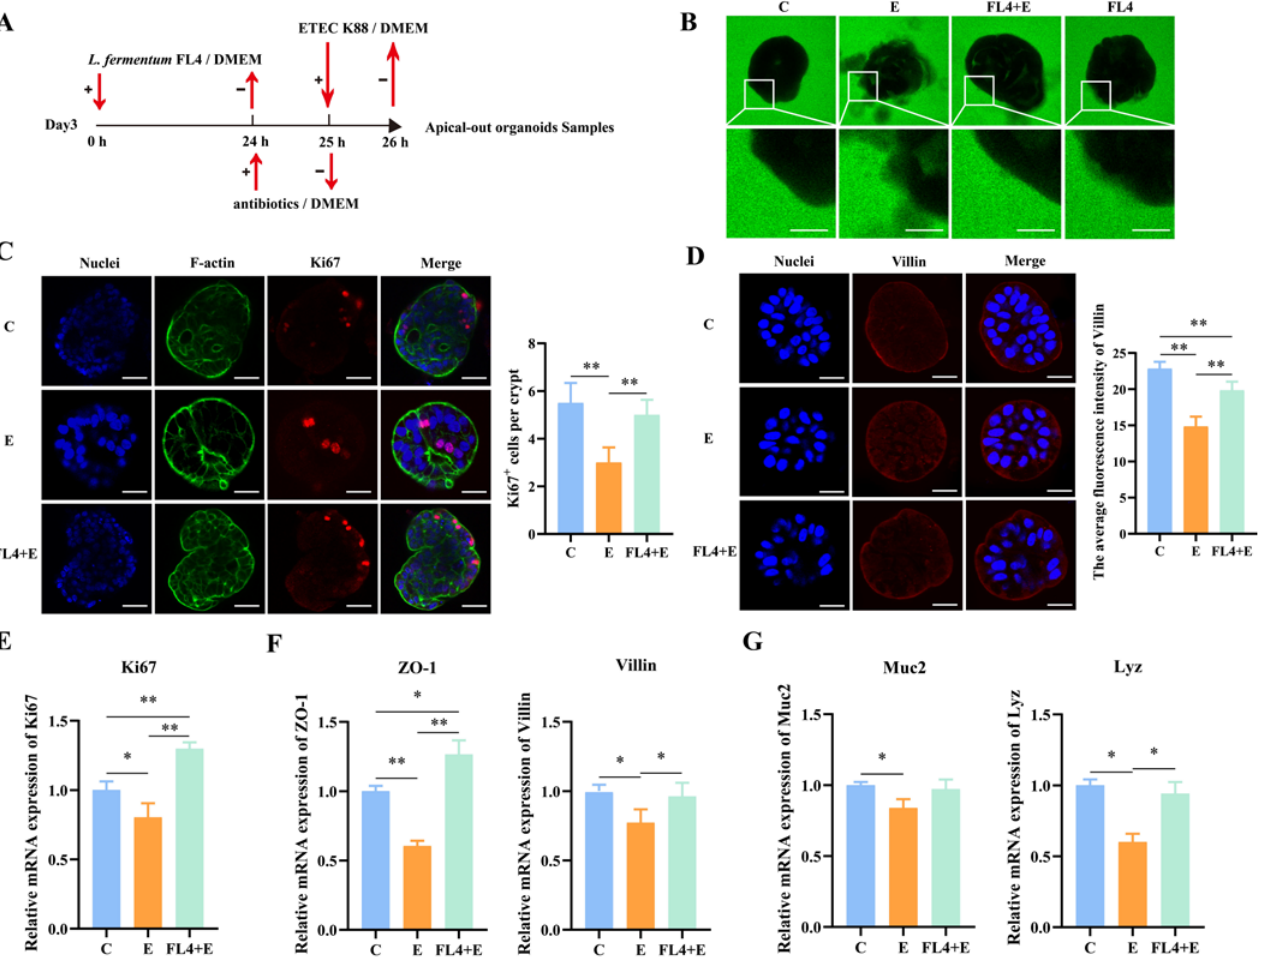
Figure 8. L. fermentum FL4 repaired the ETEC K88-induced damage to intestinal epithelium in apical-out intestinal organoids. ( A ) Experimental procedure: apical-out organoids were treated with 10 6 CFU/well L. fermentum FL4 at 0 h (Day 3) and then supplemented with antibiotics at 24 h. The organoids were further challenged with 10 6 CFU/well ETEC K88 and the samples were collected at 26 hours. ( B ) Apical- out organoids were imaged by using confocal fluorescence microscopy to ob- serve epithelial barrier integrity in different treatmen ts. Scale bars, 50 µm. ( C , D ) Apical-out organoids were stained with Ki67 and Villin (red). Nuclei were stained with 4′ ,6-diamidino-2-phenylindole (DAPI, blue), cytoskeletons were stained with F- actin (green). Scale bars, 20 µm. ( E ) RT-qPCR analysis of the Ki67 in organoids, n = 3. ( F , G ) The mRNA expression of the ZO -1, Villin, Muc2 and lysozyme (Lyz) in organoids, n = 3. * p < 0.05, ** p < 0.01.